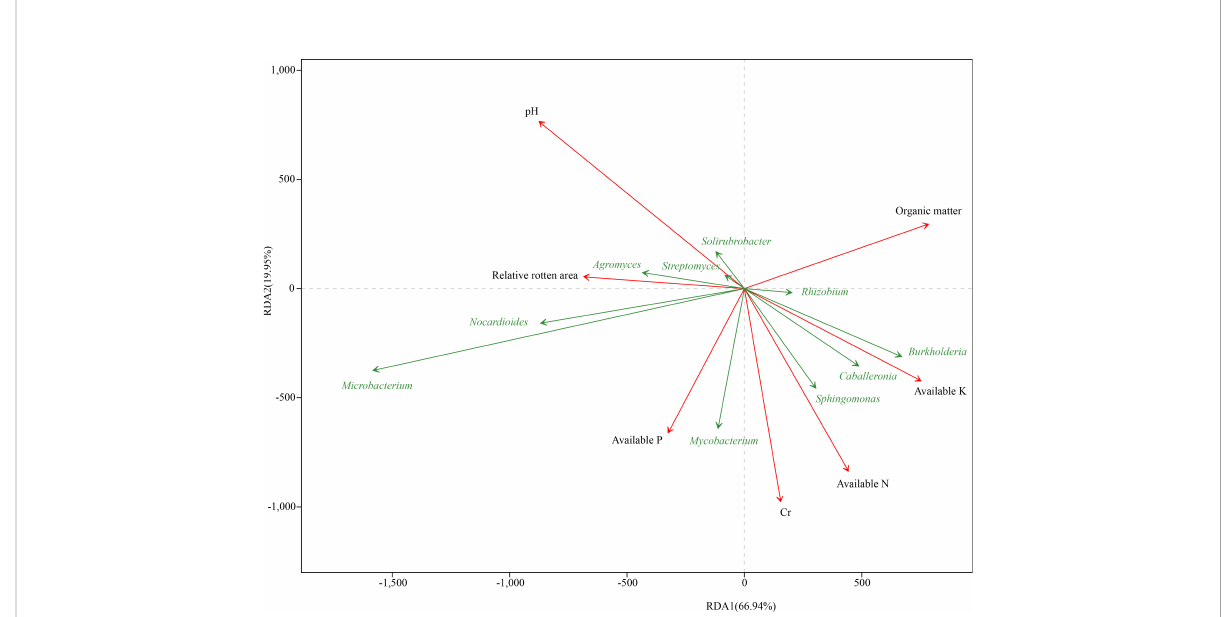
FIGURE 2 Redundancy analysis of rhizospheric genera corresponding to soil and corm properties. The 10 best- fi tting genera are